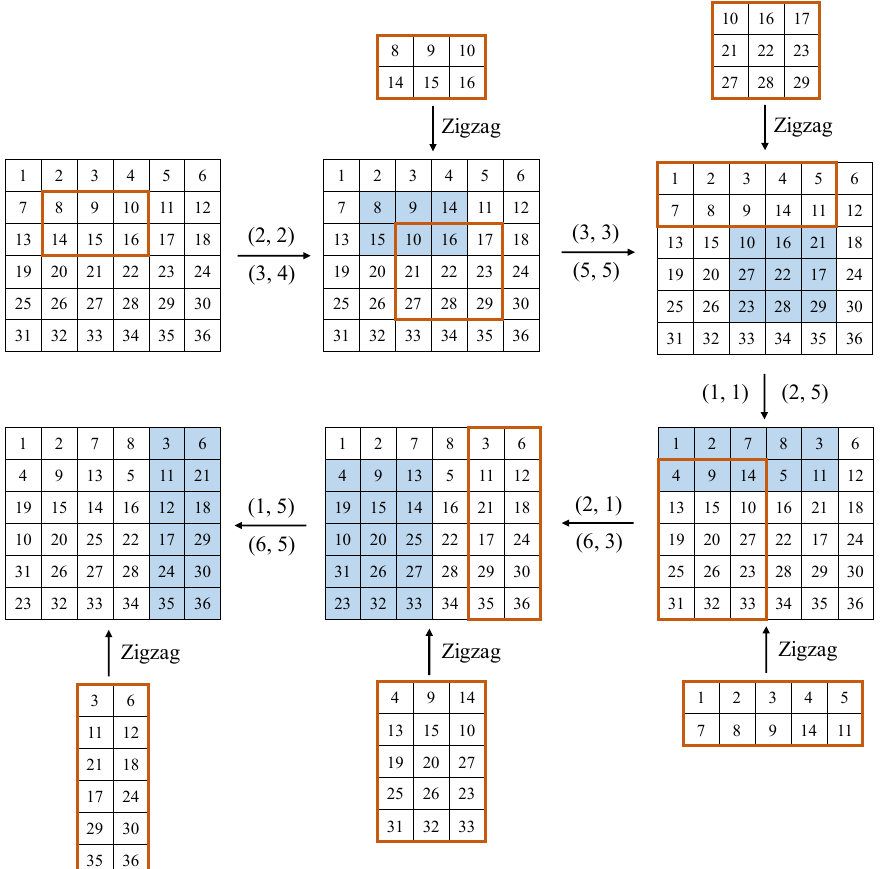
Figure 6. Dynamic block Zigzag transformation (The red part is the dynamic selected transformation range, and the blue part is the value after each round of transformation. Arrows mean that the values in the red part are replaced by the blue part.).